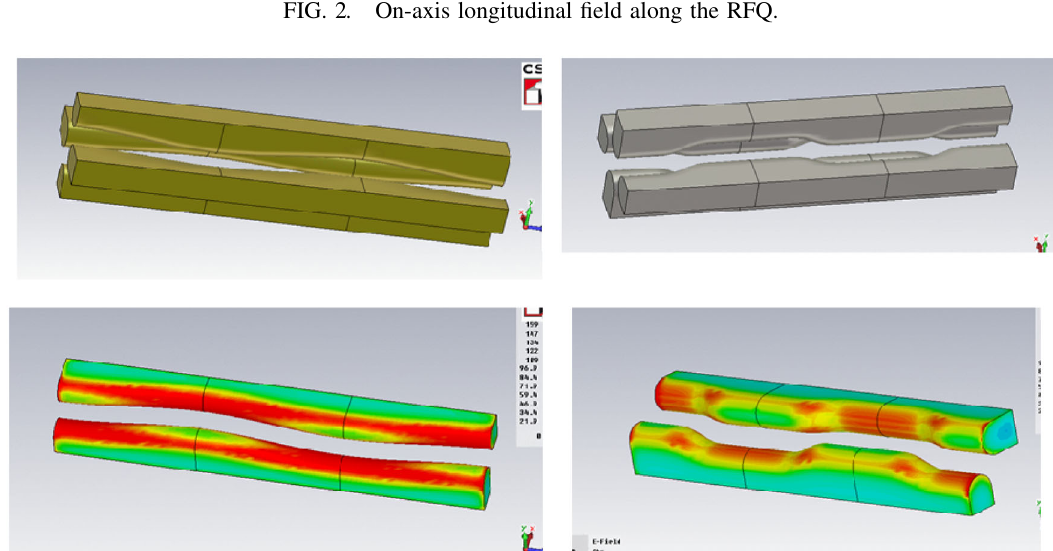
FIG. 3. Sinusoidal (left) and trapezoidal (right) vane tip modulations in EM-STUDIO models. The bottom pictures show surface electric field distribution.